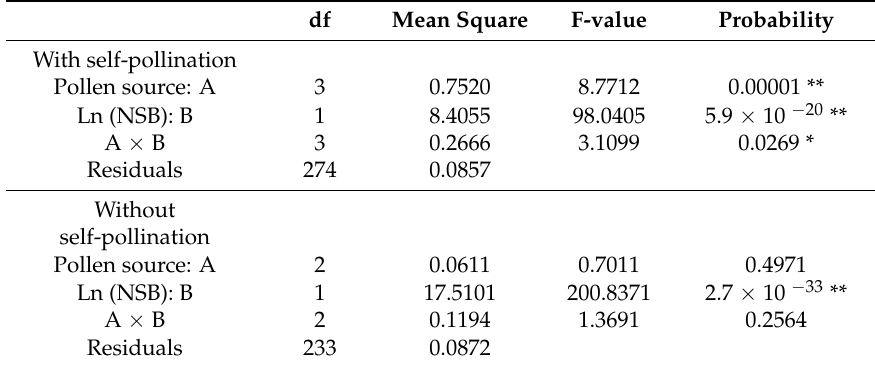
Table 4. Results of ANCOVA determining the differences in the regression coefficients between NSB and BW among pollen sources in the 2015 experiment with or without self-pollination. df Mean Square F-value Probability